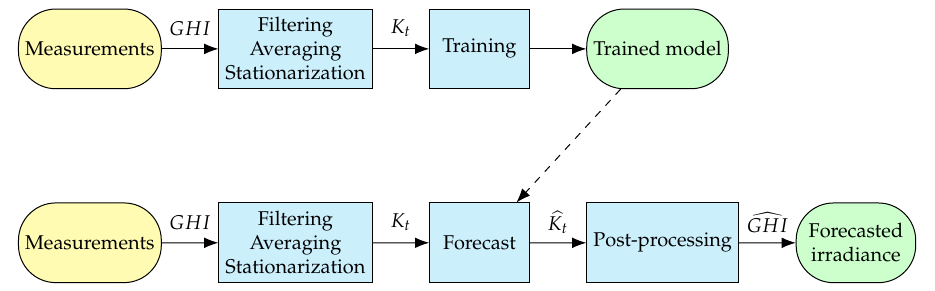
Figure 3. Training and forecast block